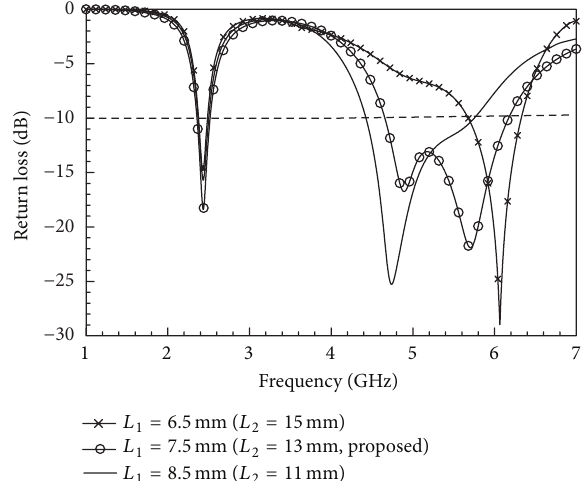
Figure 3: Simulated return loss versus frequency for various 𝐿 1 ; 2𝐿 1 + 𝐿 2 is fixed as 28 mm and 𝐻 = 3